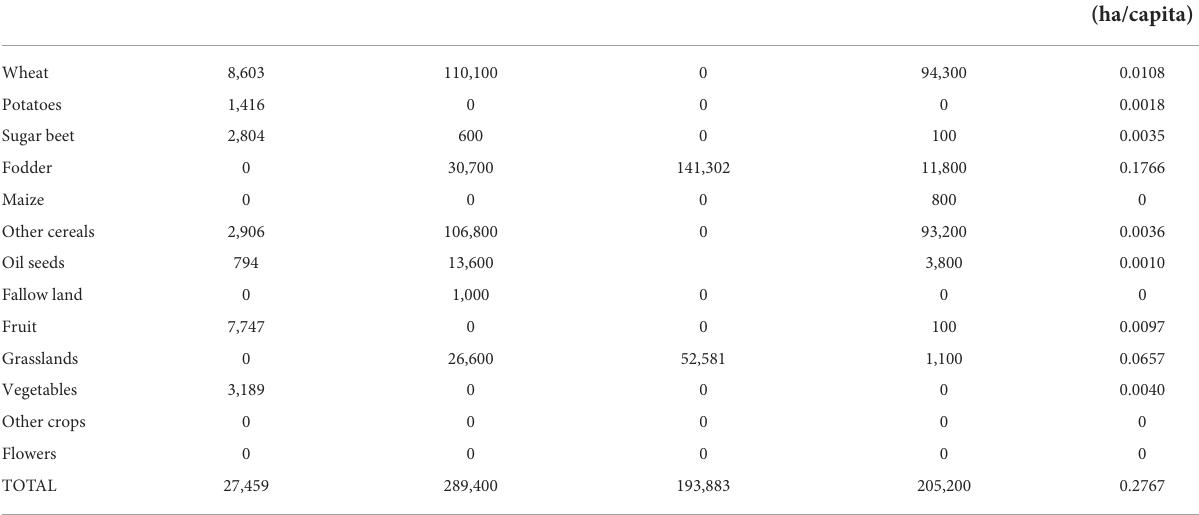
TABLE 2 Food demand and supply for Copenhagen: status quo (in hectares). Food